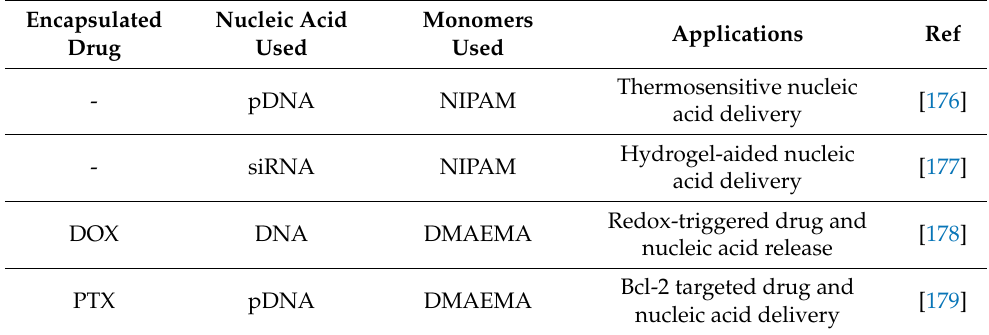
Table 2. A review of the literature on the synthesis of modern polyplexes using normal ATRP technique.